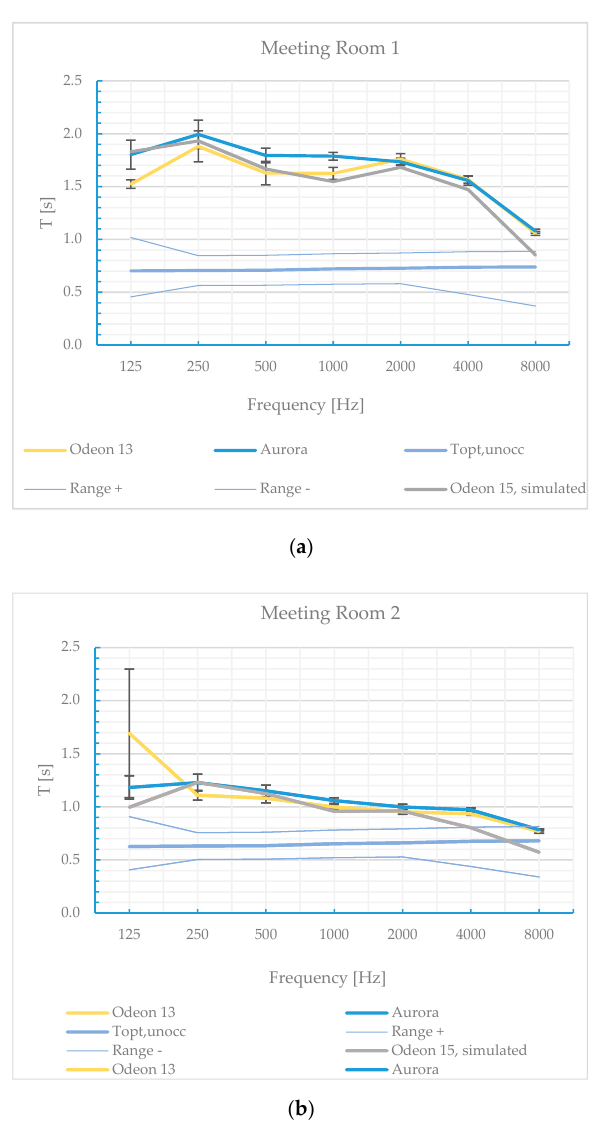
Figure 7. Octave band Reverberation Time in the Mr1 ( a ) and Mr2 ( b ). Measured T 20 with ODEON 13 Room Acoustic Measurement System and the Aurora plug-in, version 3.0, and optimal Reverberation Time in unoccupied conditions, T opt,unocc , with its target range as a function of frequency. The error bars represent the standard deviation across different measurement positions.